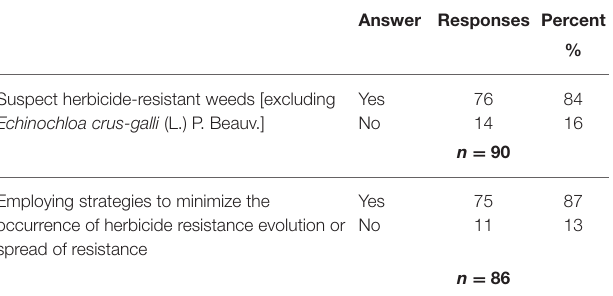
TABLE 3 | Respondents’ suspicion of the existence of herbicide-resistant weeds [excluding Echinochloa crus-galli (L.) P. Beauv.] in the rice fields they farm or scout and whether they were implementing strategies to minimize the occurrence of herbicide resistance evolution or spread of